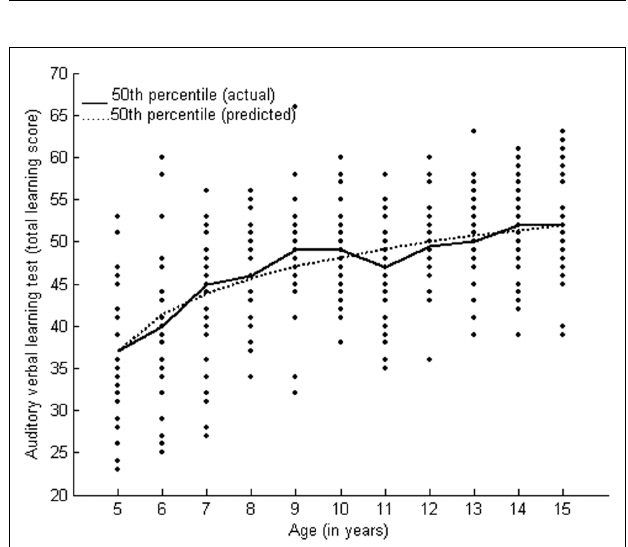
FIGURE 4 | Presents an exemplar of logarithmic fit growth curve for verbal